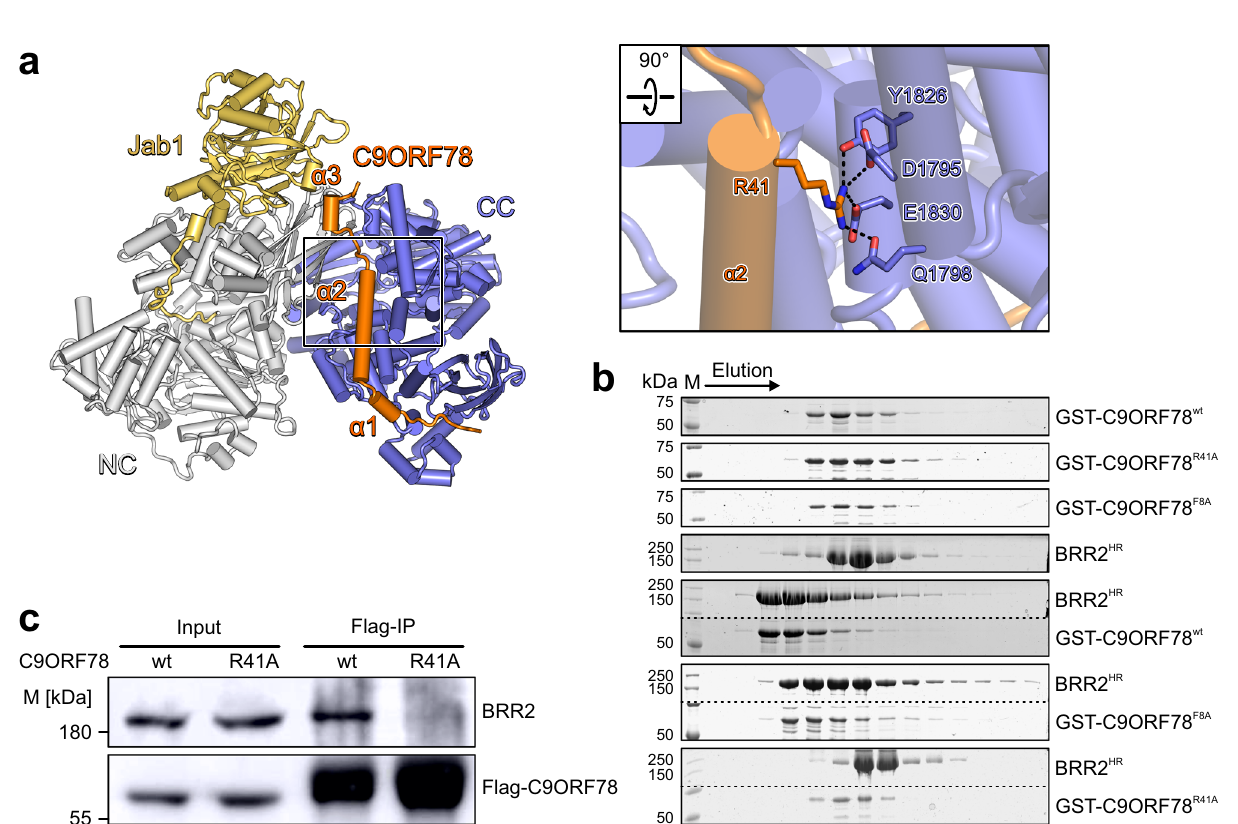
Fig. 3 Mutational disruption of the C9ORF78-BRR2 HR interaction. a Close-up view of C9ORF78 residue R41 interacting with BRR2 residues Y1826, D1795, E1830 and Q1798. b SDS-PAGE gels showing elution fractions from analytical SEC, monitoring interactions of GST-C9ORF78 wt , GST-C9ORF78 F8A and GST- C9ORF78 R41A with BRR2 HR . The same elution fractions from runs under identical conditions are shown. Protein bands are identi fi ed on the right. M, molecular mass marker. In the third and fi fth panel, upper and lower regions of the same gels were spliced together. Dotted lines, splice positions. Independent experiments were conducted twice with similar results. c Flag-IP followed by Western blot with C9ORF78 wt or C9ORF78 R41A . Immunostaining against BRR2 and Flag-tag. M, molecular mass marker. Independent experiments were conducted twice with similar results. Source data for b and c are provided as a Source Data fi